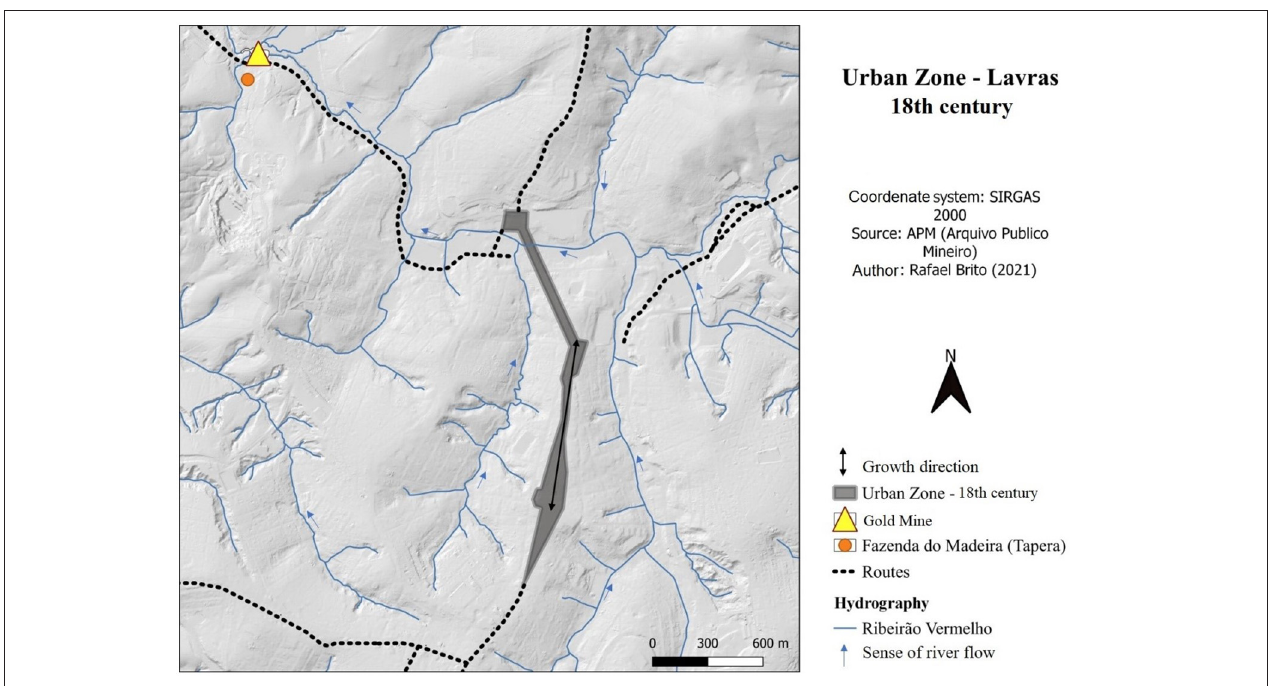
FIGURE 4 | Formation of the urban area of Lavras in the Ribeirão Vermelho basin (eighteenth century). Source: Sousa R. B. et al. (2021).